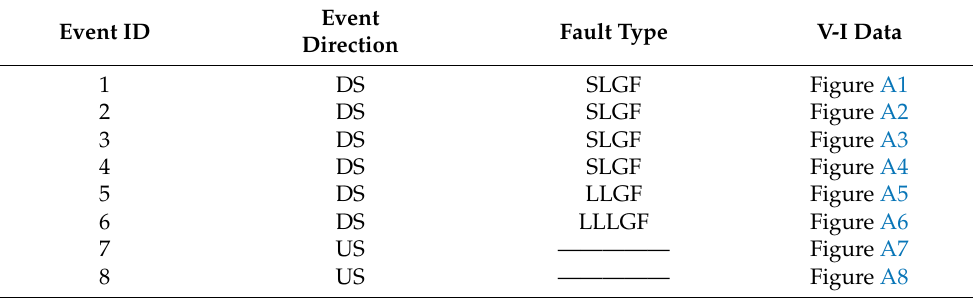
Table 4. Example of data provided by PQMS.